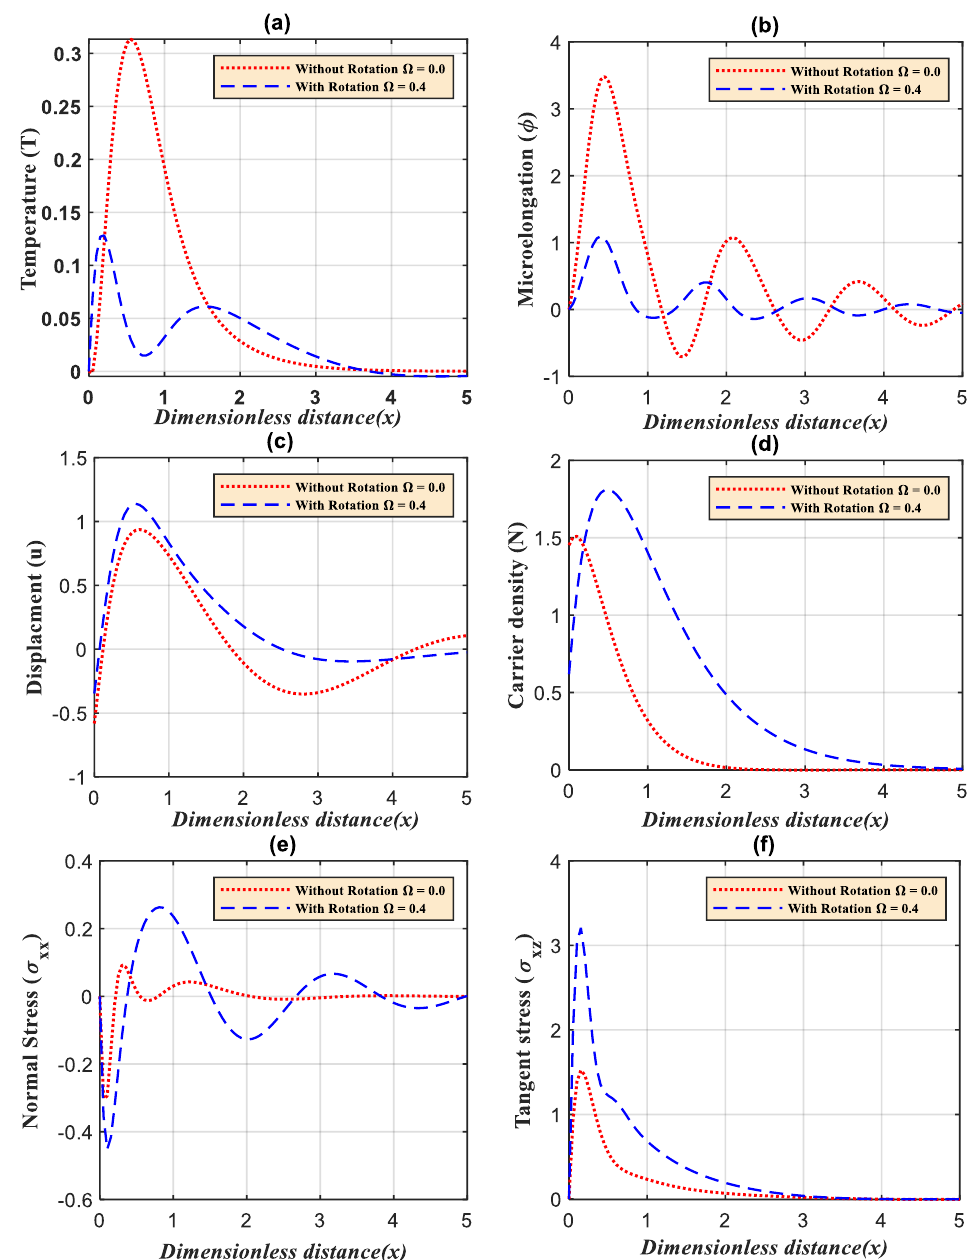
Figure 3. ( a – f ) The variations of the main physical fields versus the horizontal distance in the case of the GL model with rotation field influence and without rotation field influence.